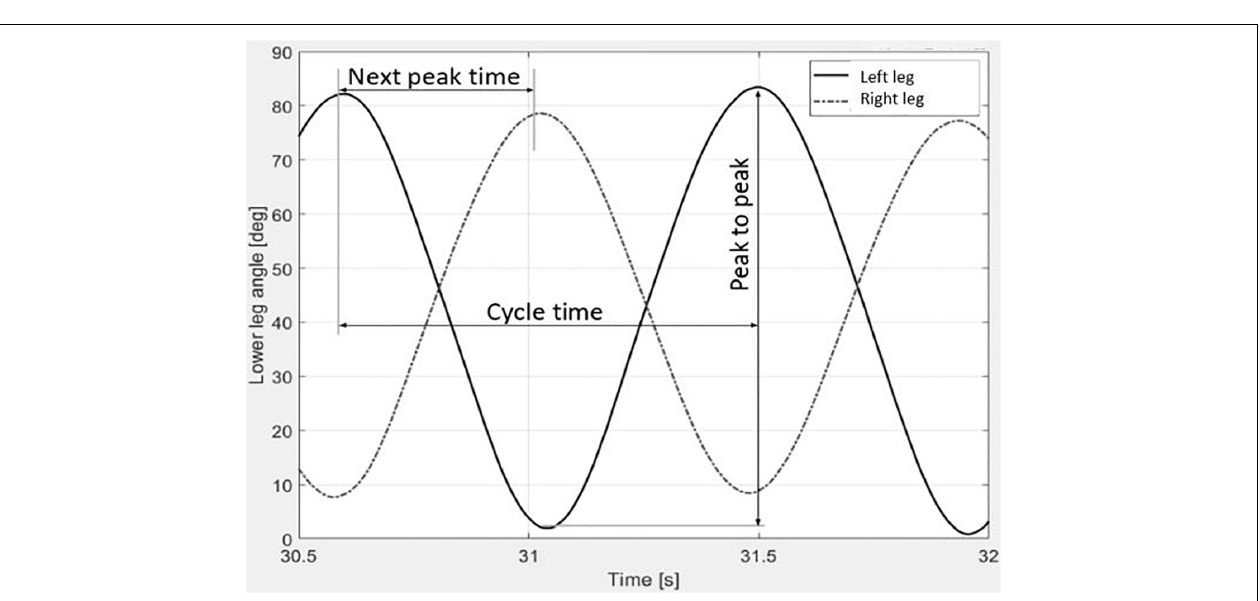
FIGURE 1 | Representation of the seated antiphase interlimb coordination task. Subjects make simultaneous left and right knee flexion and extension antiphase movements.